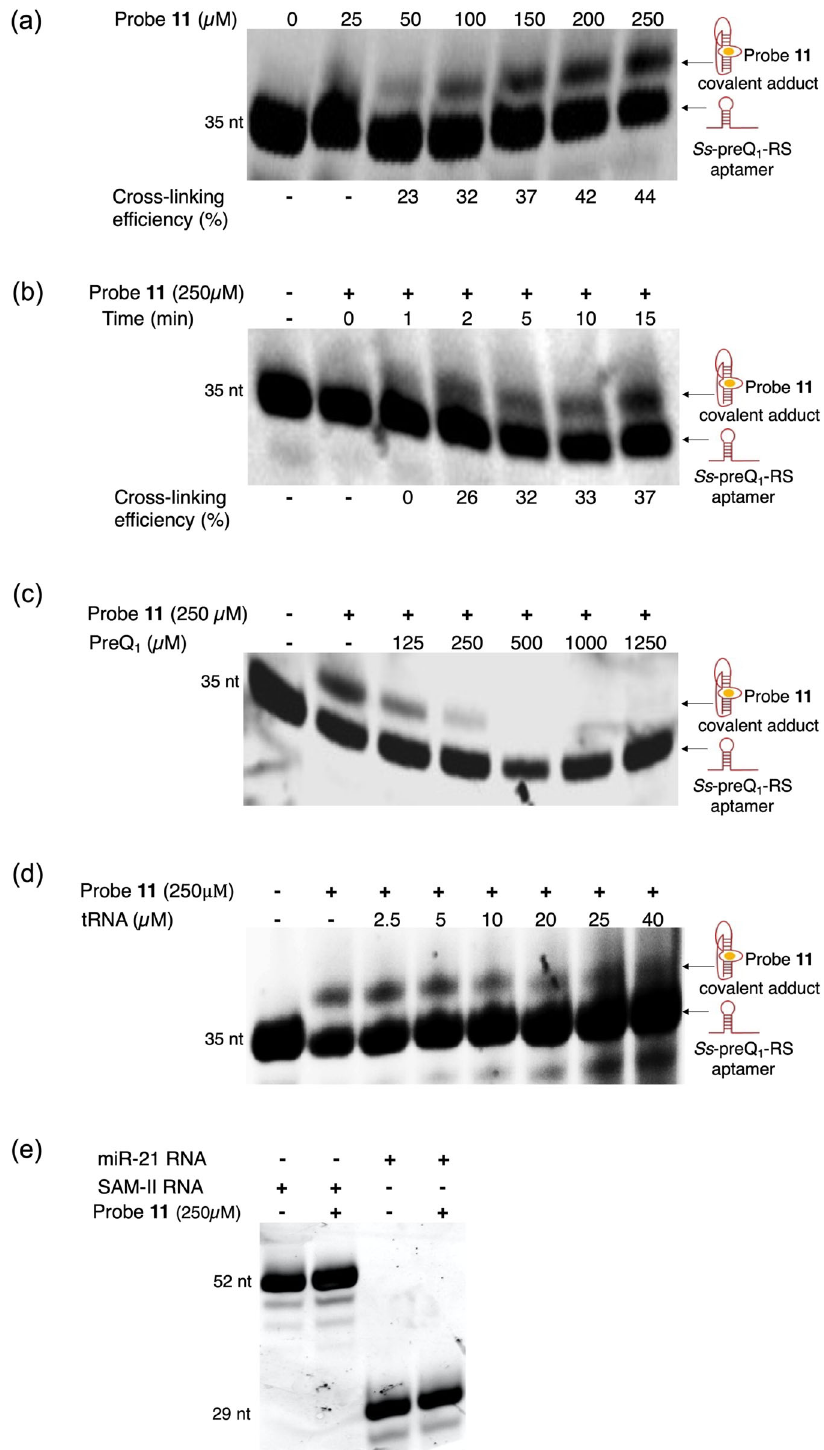
Fig. 2 Biochemical optimization of photocrosslinking and competition experiments to evaluate the speci fi city of compound 11 for the Ss -preQ 1 -RS aptamer. a Dose-dependent crosslinking ef fi ciency of compound 11 . b Time-dependent crosslinking ef fi ciency of compound 11 . Competition experiments in the presence of c PreQ 1 and d tRNA. e PAGE analysis to assess crossreactivity of compound 11 with other structured RNAs shows no quanti fi able modi fi cation of either miR-21 RNA or SAM-II RNA. Values for crosslinking ef fi ciency are reported as the mean ± standard deviation of three replicate experiments. Source data are provided as a Source Data fi